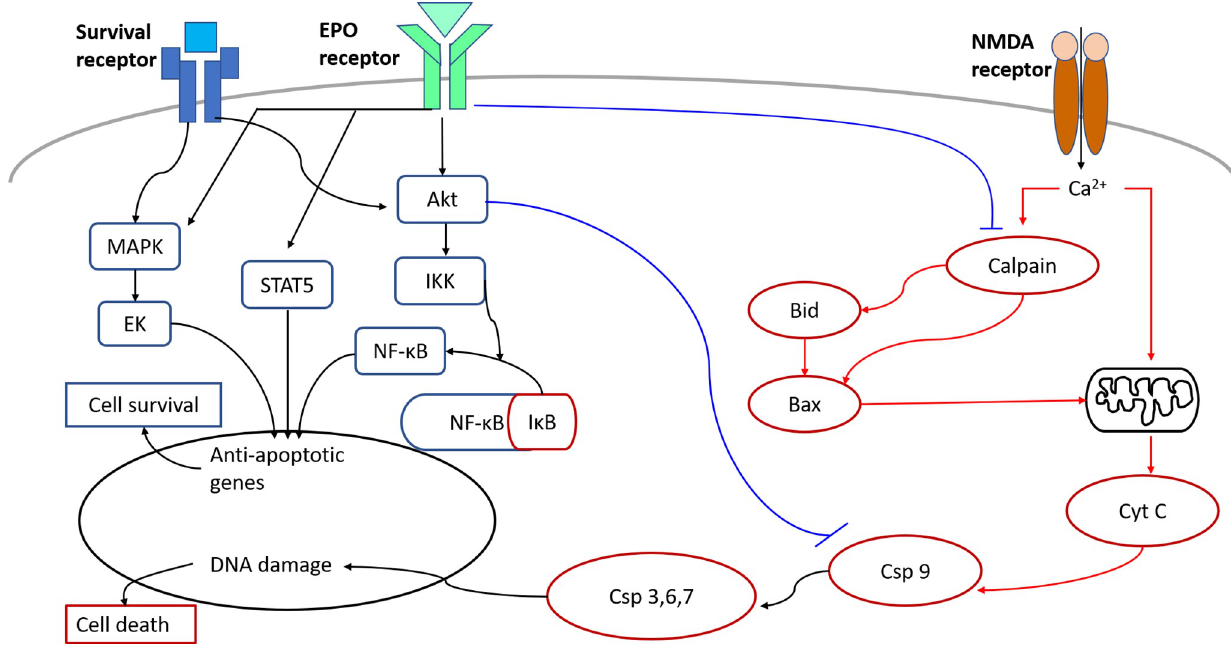
Fig 7. The possible signal transduction pathways: Activated by NMDA-mediated neurotoxicity (red line) and downregulated by EPO-mediated neuroprotective (blue line) in the apoptotic pathway.